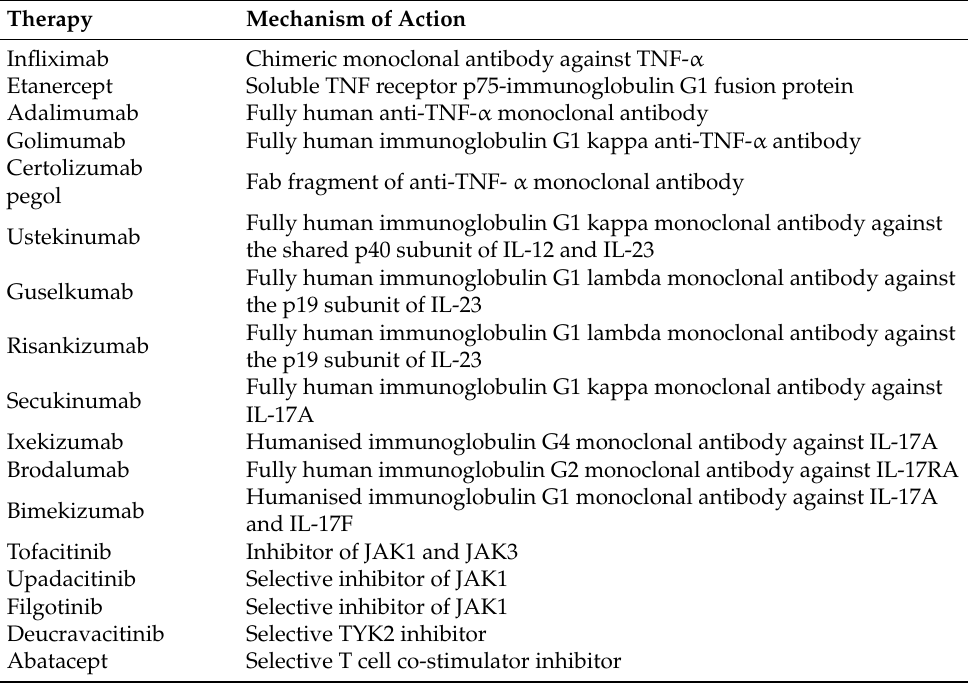
Table 1. Targeted therapies for psoriatic